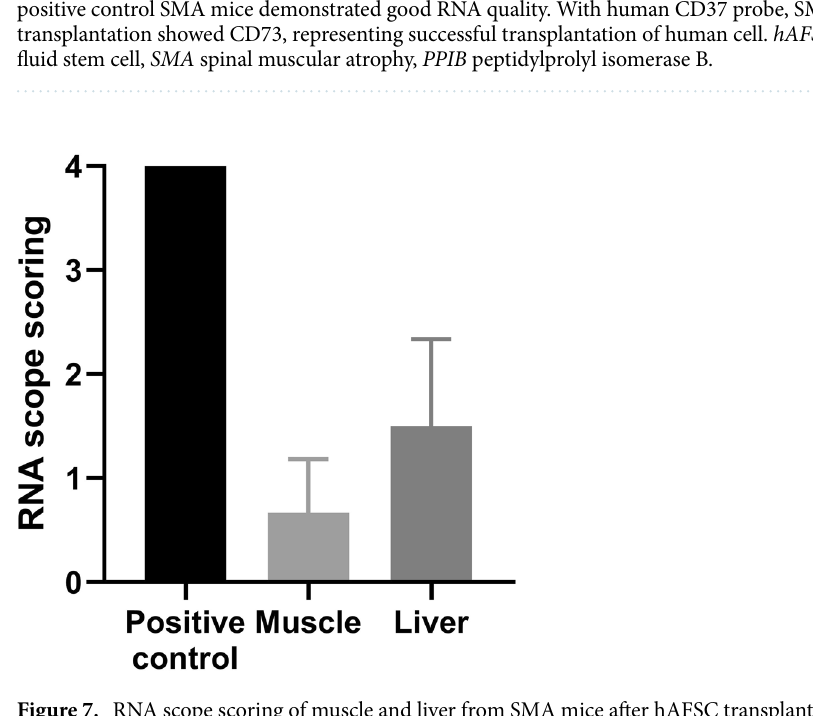
Figure 6. hAFSC transplantation of muscle and liver in SMA mice by RNA scope. With mouse PPIB probe, positive control SMA mice demonstrated good RNA quality. With human CD37 probe, SMA mice with hAFSC